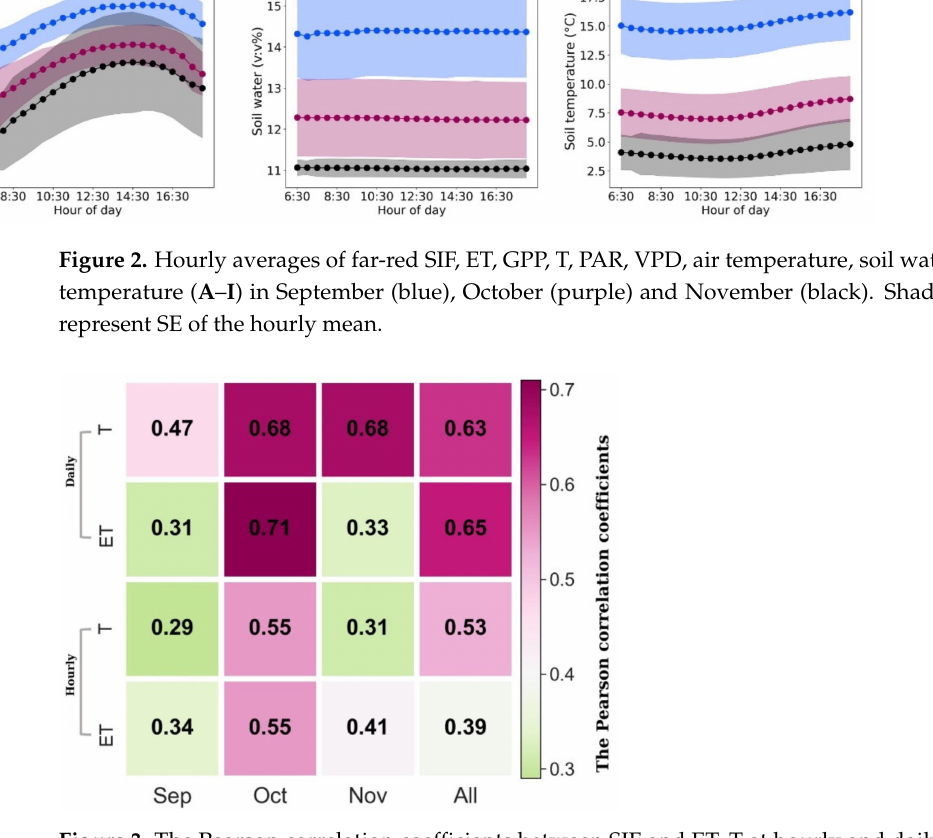
Figure 3. The Pearson correlation coefficients between SIF and ET, T at hourly and daily scales for different months in the fall